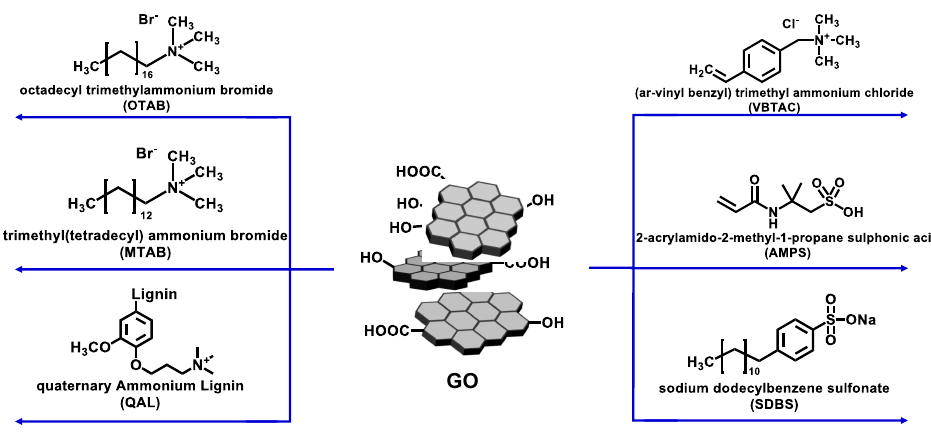
Figure 1. The chemical structures of graphene oxide (GO) and different modifiers.